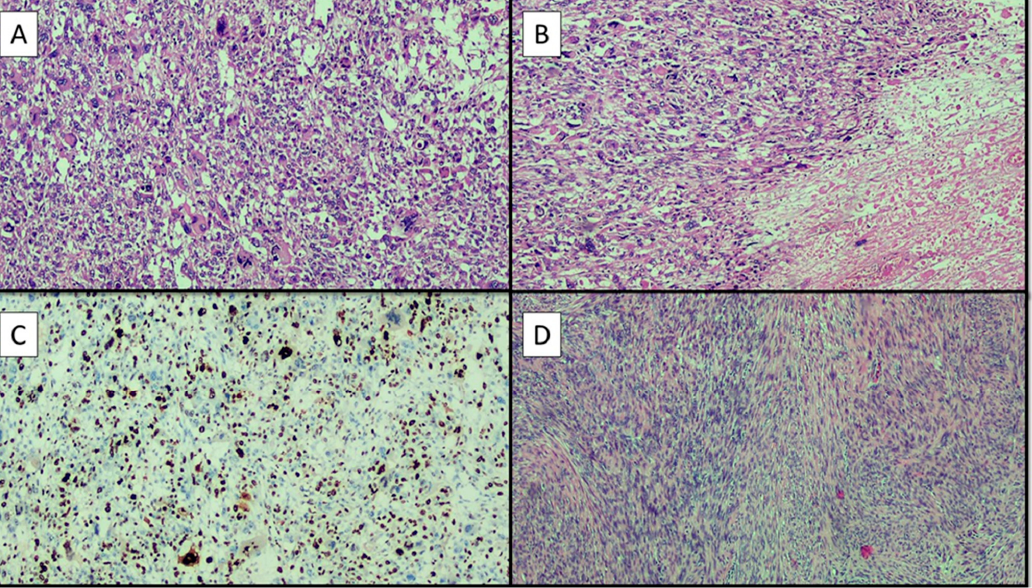
Figure 4. A collage of histological images of the case presented: ( A ) Histological preparation showing a proliferation of high-grade spindle and/or pleomorphic cells with eosinophilic cytoplasm, often forming interlacing but disorganized fascicles. Note diffuse pleomorphism of the nuclei (hematoxylin–eosin, original magnification 4×); ( B ) in this histological preparation it is possible to appreciate on the right the presence of tumoral necrosis. (hematoxylin–eosin, original magnification 4×); ( C ) immunohistochemical preparation with antibody anti-Ki67 antigen: note the high presence of neoplastic cells immunolabeling in brown (immunohistochemistry, original magnification 4×); ( D ) histological picture of a leiomyoma of this patient. Note the almost total